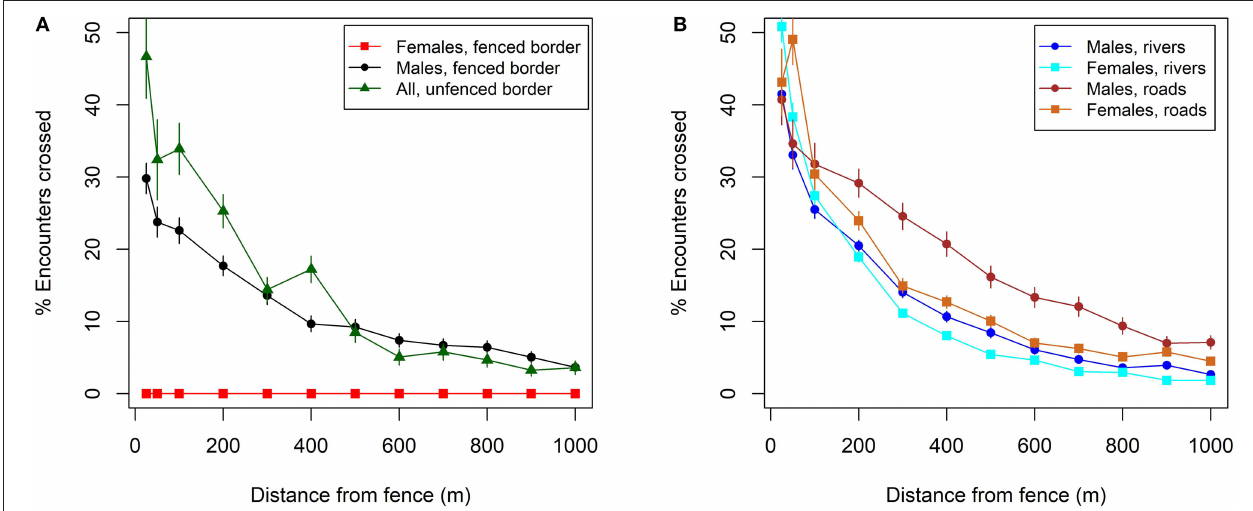
FIGURE 2 | (A) Percentage of times that a Namibia-Botswana border fence was crossed during an elephant’s next hourly move, as a function of distance to fence at previous time step. Red = females, black = males, green = crossings (both male and female) of an unfenced section of the Namibia-Botswana border. (B) Percentage of times that roads and rivers were crossed during an elephant’s next hourly move, as a function of encounter distance to barrier at the previous time step. In both cases, distances to barriers were binned into 50, 100-m, and then every 200-m classes, and the mean and Bernoulli-trial standard deviation of fence crossing percentages were plotted.